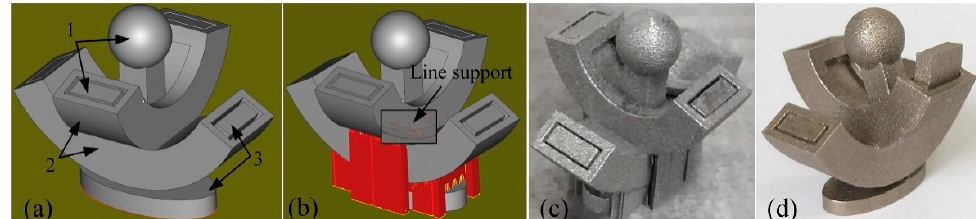
Figure 14. An example of non-assembly mechanical structure with two degrees of freedom: ( a ) model;